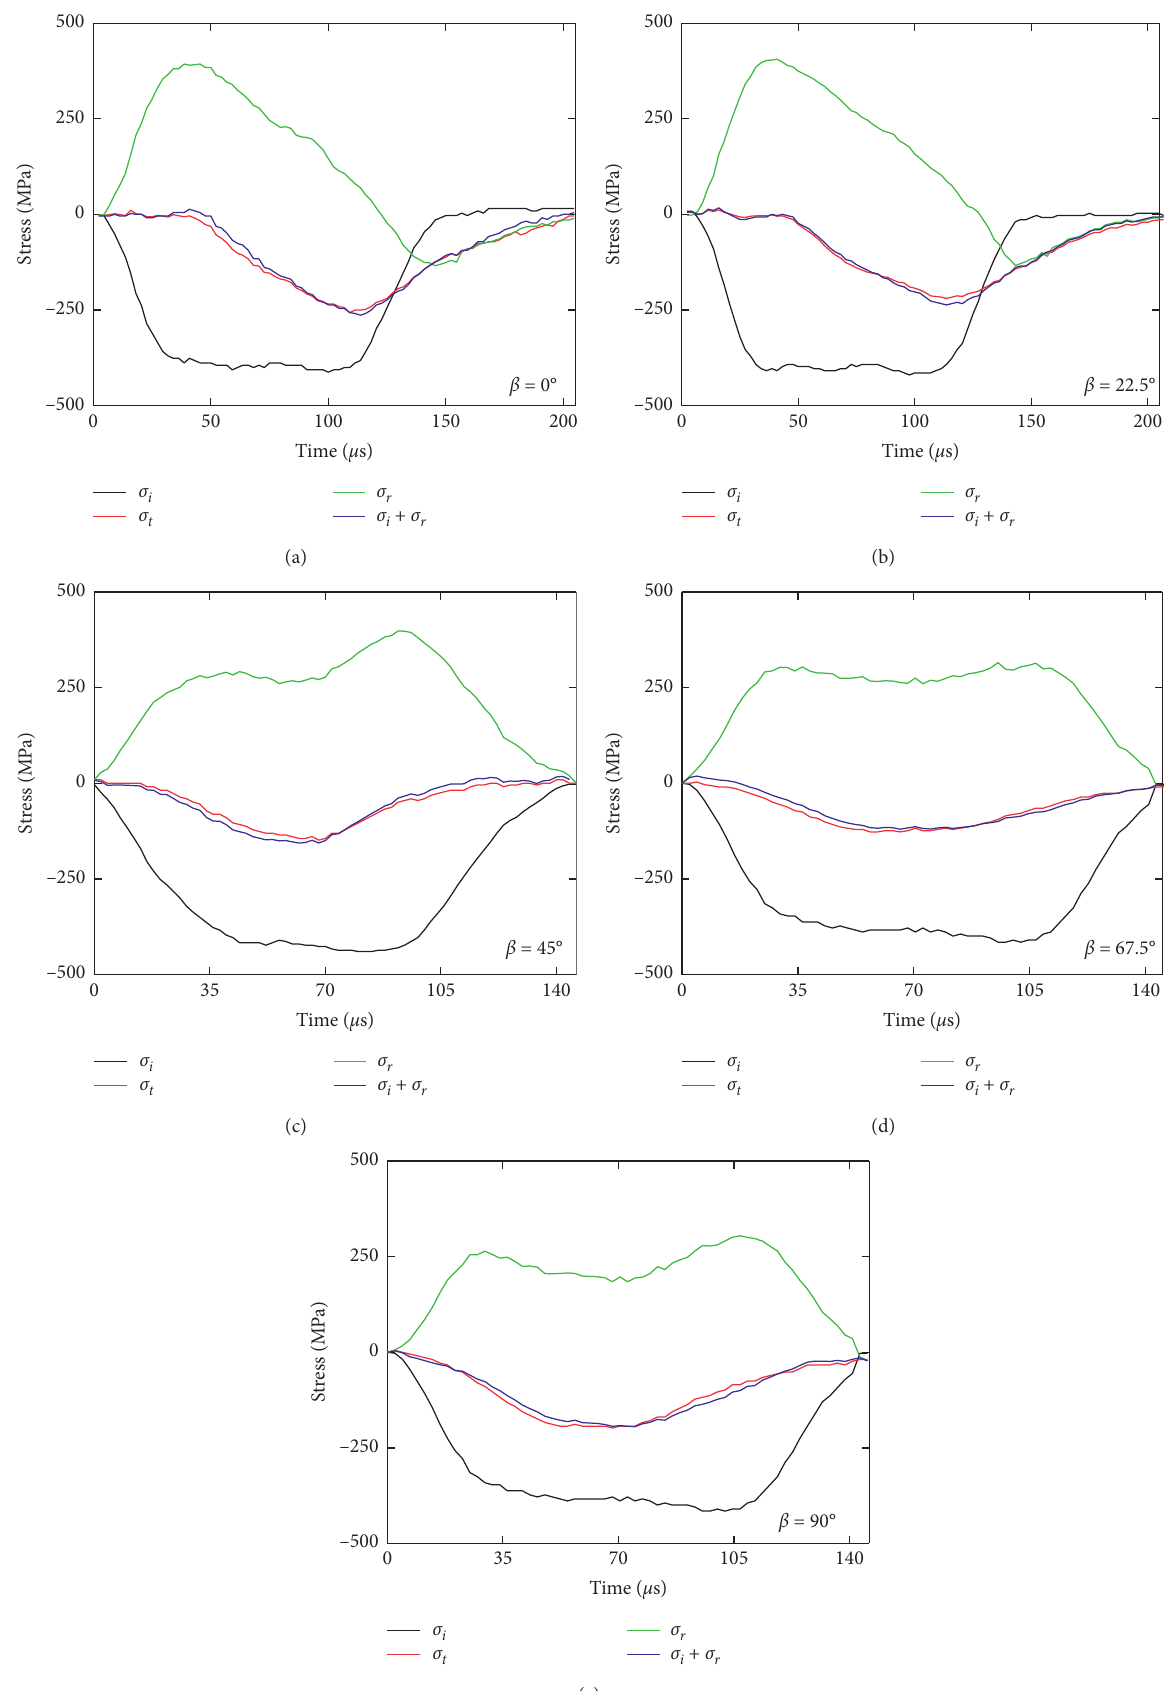
Figure 4: Three-wave method to check experimental stress